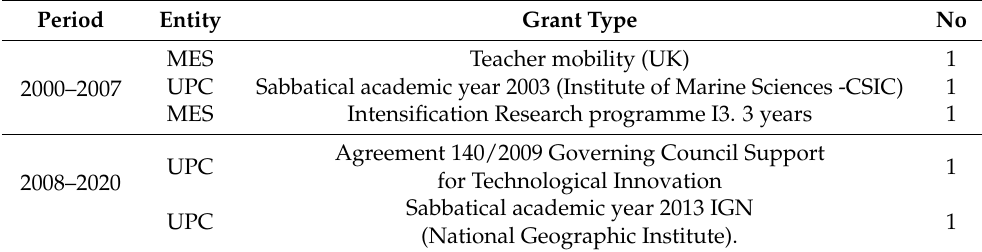
Table 7. Periods of intensification in research of SARTI teachers.